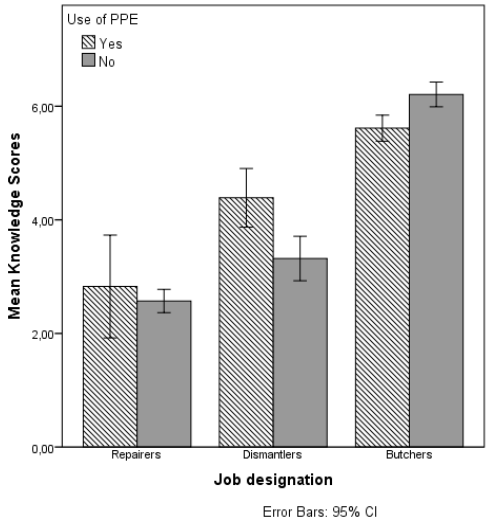
Figure 5. Mean knowledge score by job designation and use of PPE.